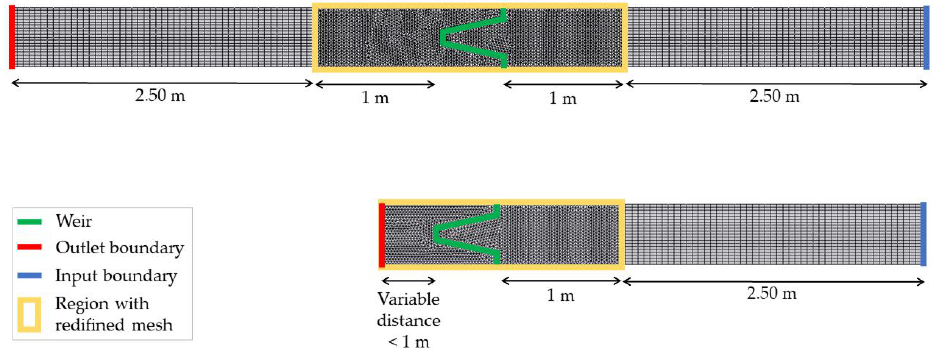
Figure 4. Numerical mesh used in the first and second experimental campaign ( above ) and in the third campaign ( below ). The numerical models shown in this figure corresponds to Weir 1.